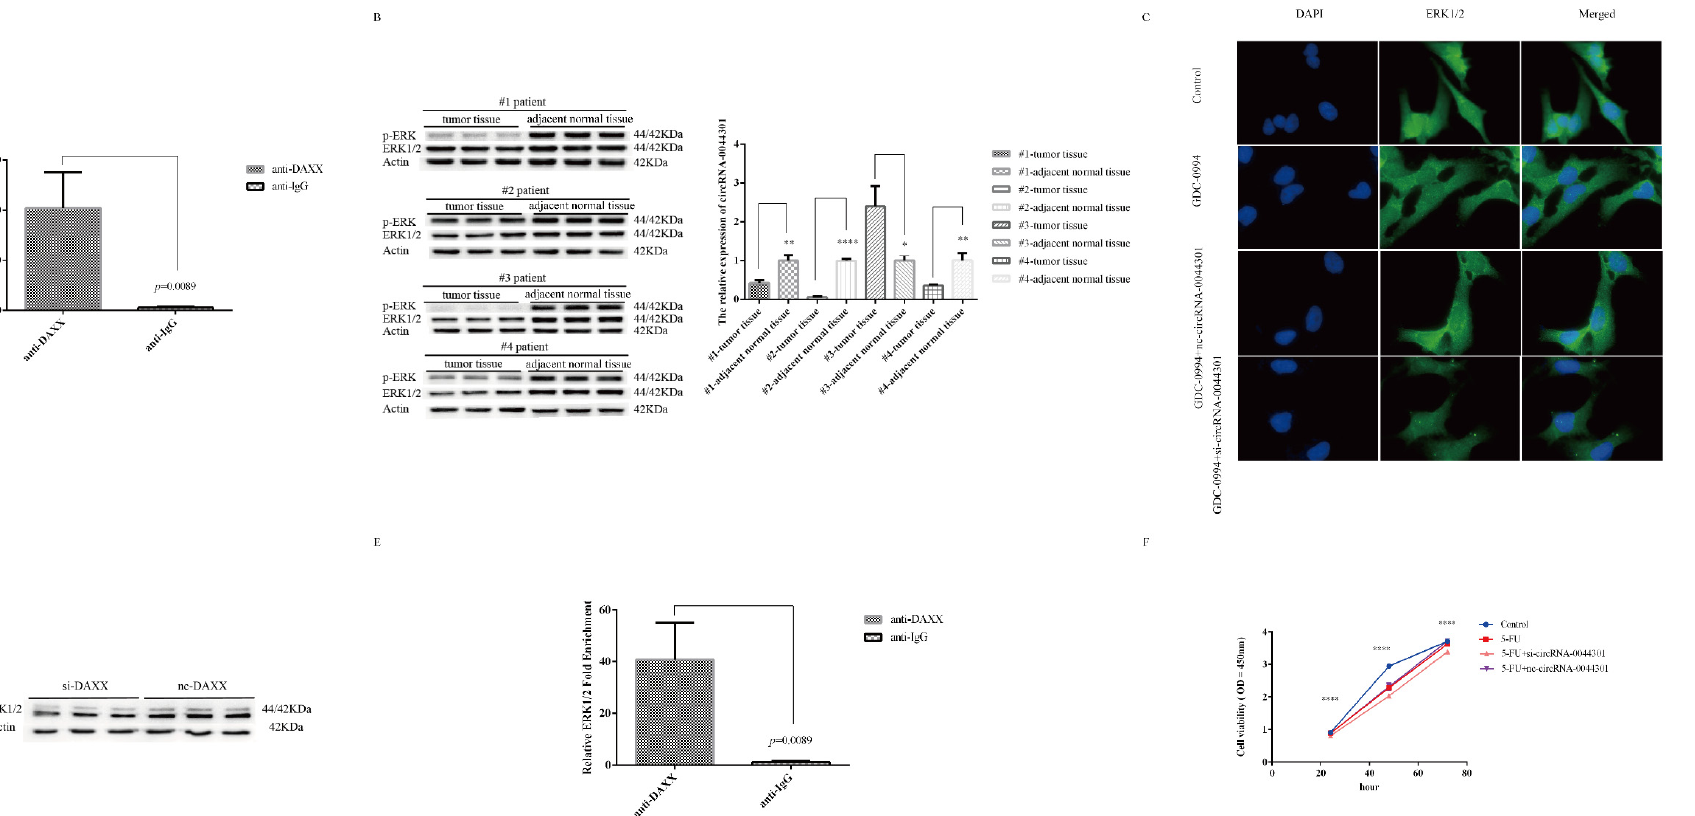
Figure 8. Knockdown of circRNA-0044301 inhibited ERK1/2 expression and enhanced the sensitivity of cells to 5-FU. ( A ) RIP-qRT-PCR experiments confirmed the interaction between circRNA-0044301 and ERK1/2 or p-ERK. ( B ) The trends of ERK1/2 and p-ERK protein expression were generally consistent with the trends of circRNA-0044301 expression in four GC patients (only in patient #3 was the expression trend reversed, but it was consistent in the other three patients. ****: p < 0.0001; **: p < 0.01; *: p < 0.05). ( C ) IF results of ERK1/2 in cells after single GDC-0994 or combined transfection with si-circRNA-0044301 into cells; the ERK1/2 protein expression was inhibited after the addition of GDC-0994 compared with that in the control group, and when GDC-0994 was transfected with si-circRNA-0044301 into cells, ERK1/2 protein expression was further inhibited compared with that in the control group (The samples were imaged at 1000 × magnification). ( D ) WB results of ERK1/2 with si-DAXX treated cells. ( E ) RIP-qRT-PCR experiments confirmed the interaction between ERK1/2 and DAXX. ( F ) CCK-8 assay for the cell viability of GC cells after 5-FU drug and combined treatment with si-circRNA-0044301 of HGC-27 cells (****: p < 0.0001). The whole western blots are shown in Figure